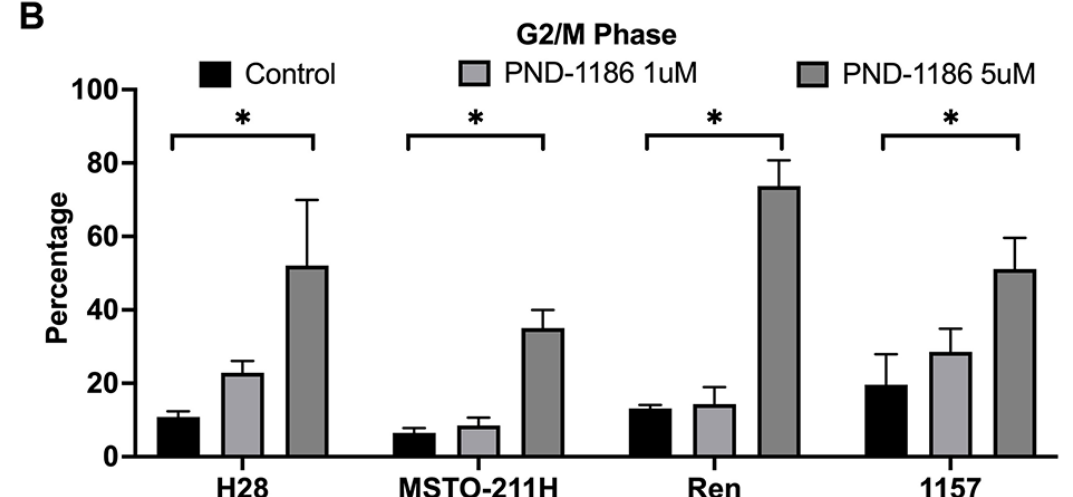
Figure 4. Cell cycle analyses were performed using a CytoFLEX (Beckman) instrument for cells treated with PND-1186 at 72 h post-treatment at the concentrations specified on the graph. ( A ) Representative cell cycle analysis on different phases are shown. ( B ) The percentages of the G2/M phase for each cell line are plotted, and statistically significant differences with respect to the untreated control are indicated with *.